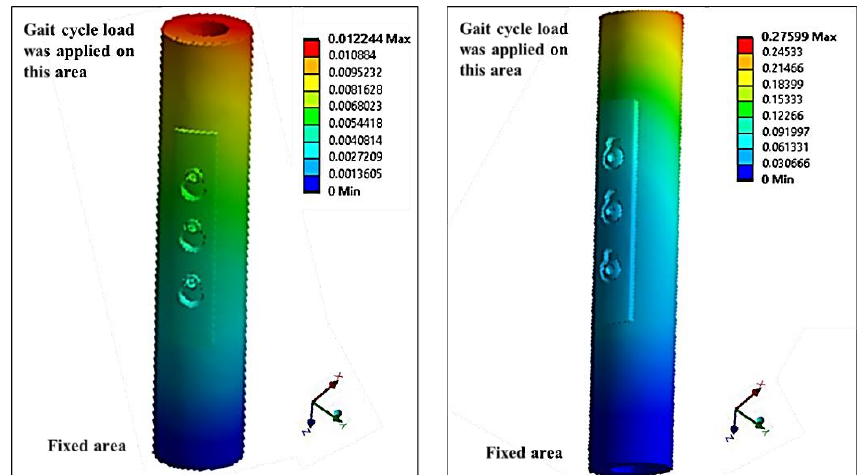
Figure 10. The total displacement (mm) in the 3D model of the plate with screws perpendicular to the plate. The variable angle locking screws (VALS) model ( left ) and the variable angle nonlockimg screws (VANS) model ( right ). Bioengineering 2019 , 6 , x FOR PEER REVIEW